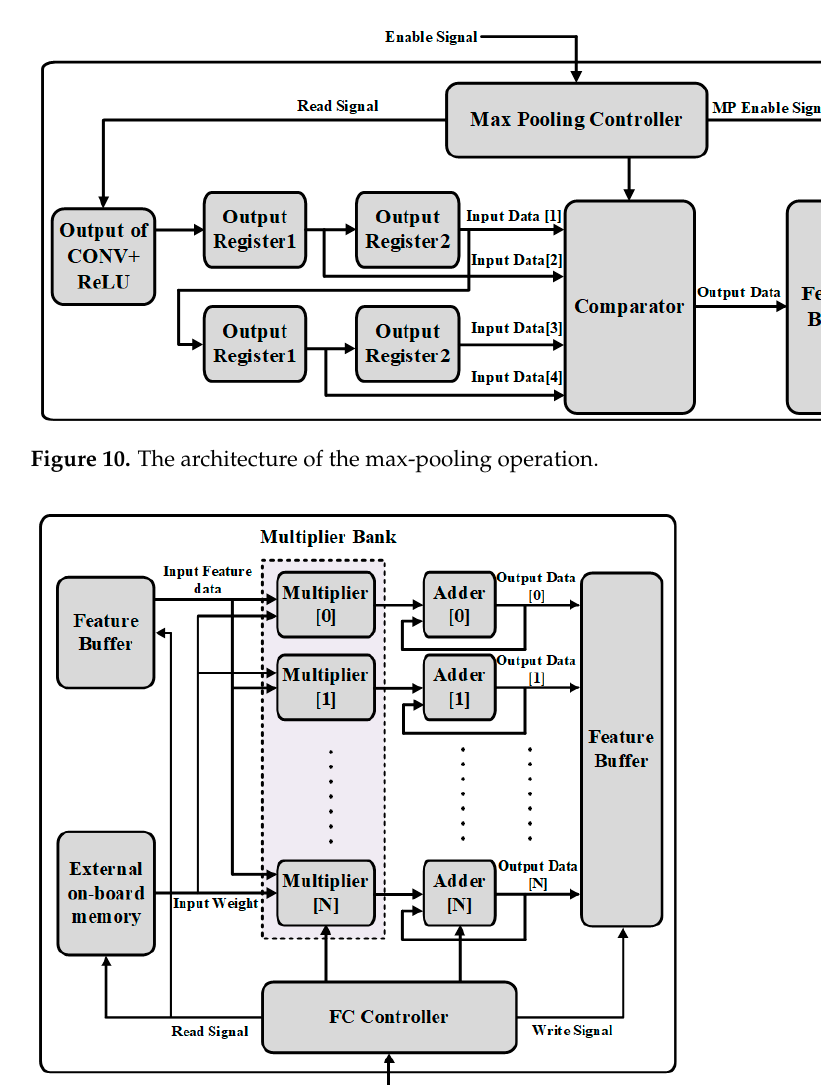
Figure 10. The architecture of the max-pooling operation.